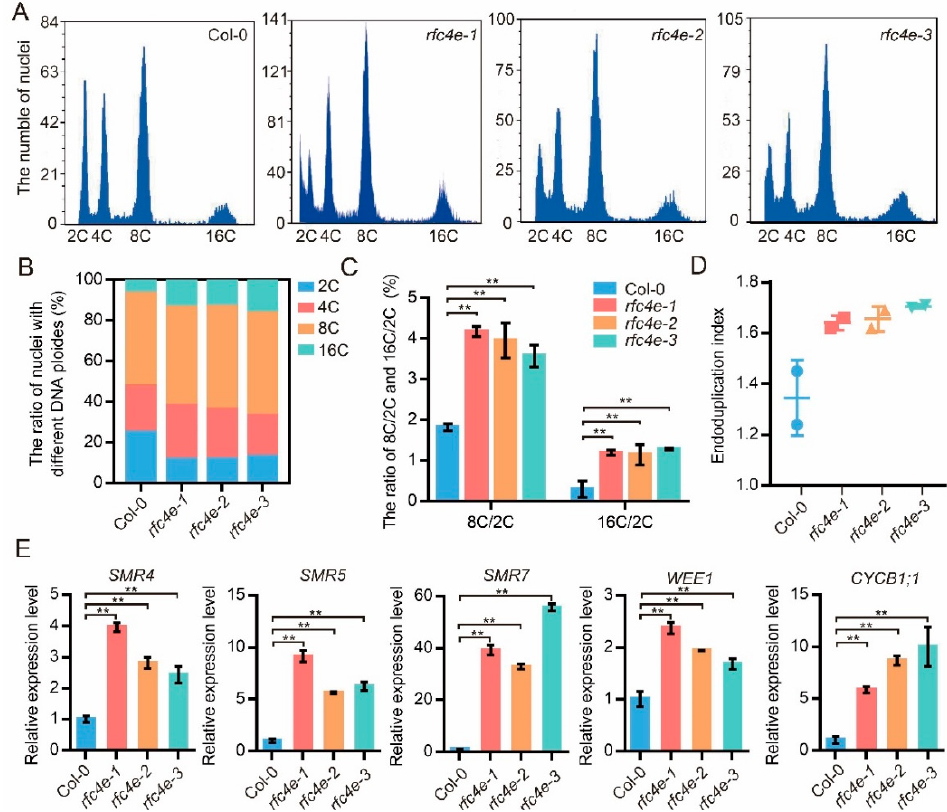
Figure 7. The AtRFC4 mutation delays the cell cycle and promotes endoduplication. ( A ) Polyploidy in first to second true leaves of 18 − d − old seedlings in Col − 0, rfc4e − 1 , rfc4e − 2 and rfc4e − 3 plants, respectively. ( B ) The percentage of nuclei with different DNA ploidies of the indicated genotypes. ( C ) The ratio of 8C/2C and 16C/2C of the indicated genotypes. Error bars indicate ± SD (** p < 0.01). ( D ) The endoduplication index of the indicated genotypes. ( E ) Relative expression levels of cell cycle genes in 12 − d − old seedlings of Col − 0, rfc4e − 1 , rfc4e − 2 and rfc4e − 3 plants under standard conditions. Data are compared to the Col − 0 value normalized at 1. The experiment was repeated twice with similar results. Error bars indicate ± SD (** p < 0.01).